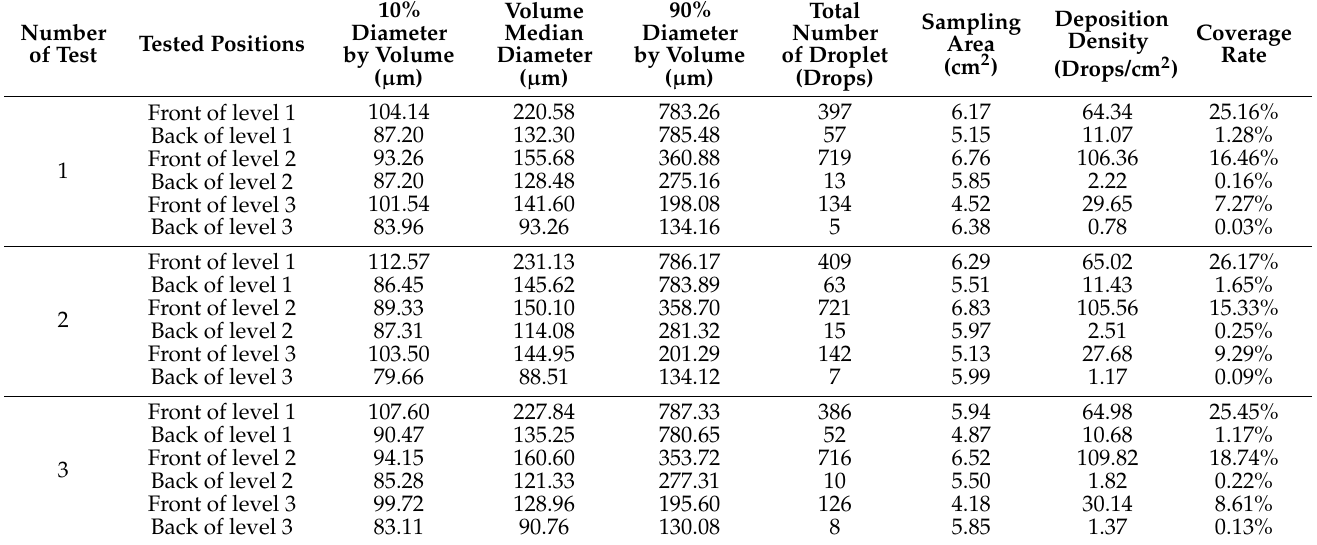
Table 9. Related parameters of spray effect